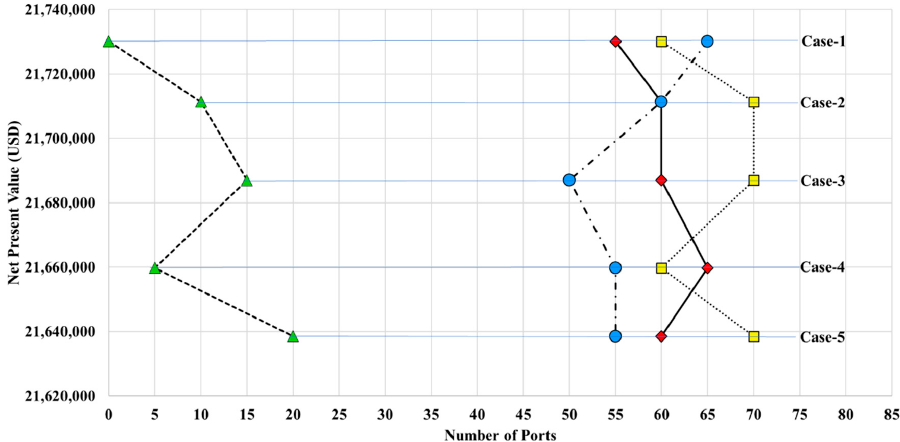
Figure 8. Optimum number of ports for top five designs.